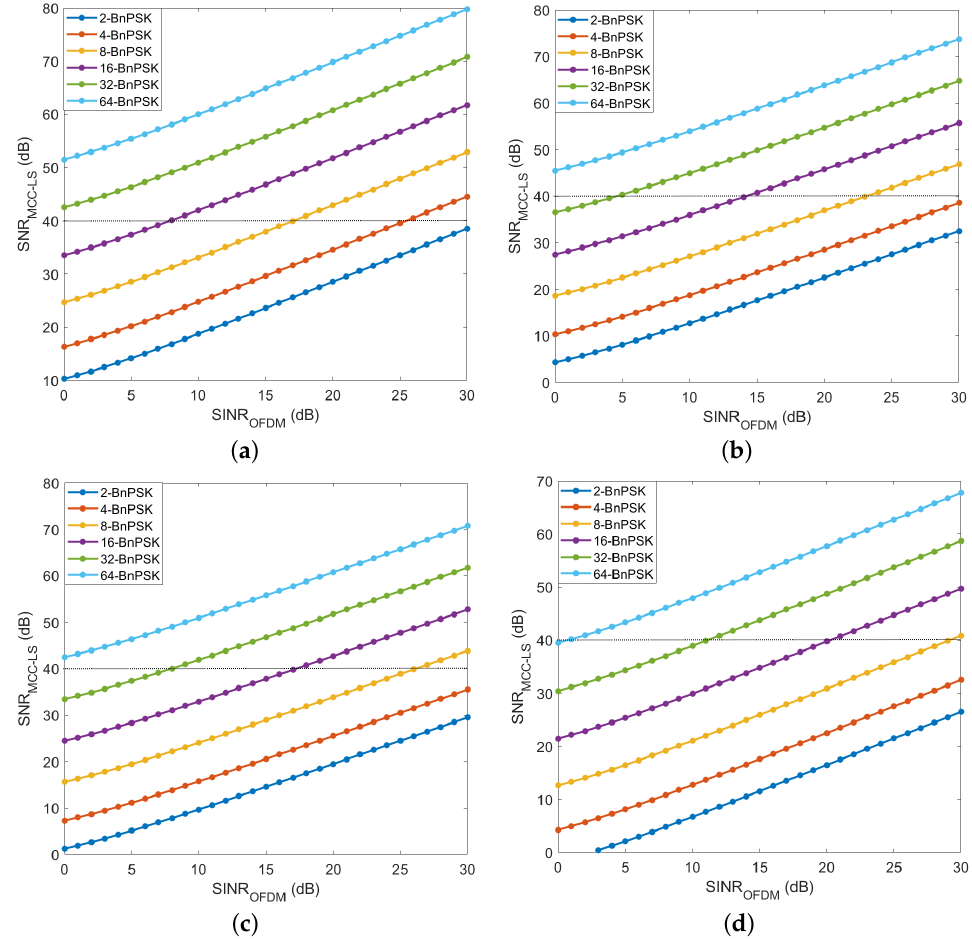
Figure 10. SNR requirements for MCC-LS with respect to SINR OFDM for varying L 1 − BPM and